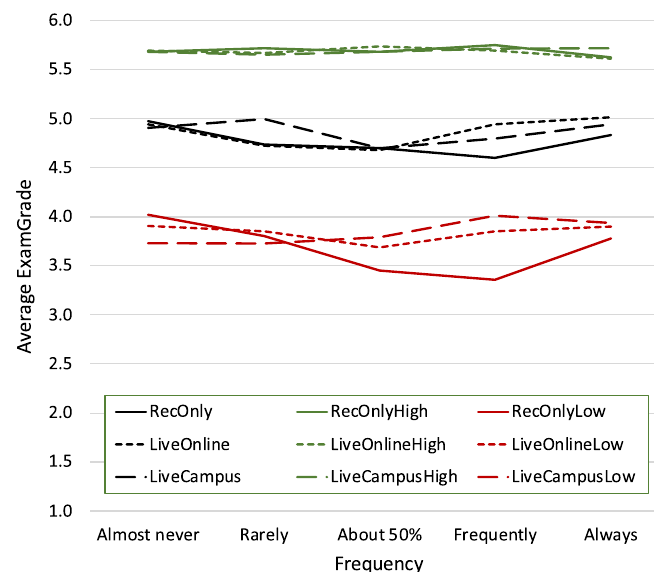
Fig. 4 Same as Fig. 2, but only for courses whose instructors indicated frequent use of clickers on a separate faculty survey. The data originates from 13 courses and 446 survey responses. The observed fluctuations, however, are statistically non‑significant ( p > 0.05 )